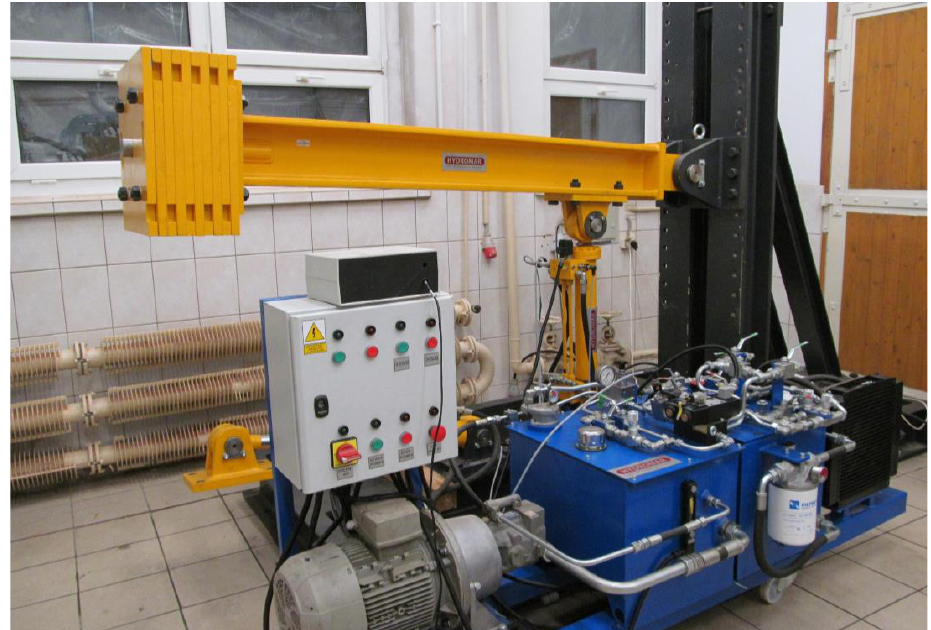
Figure 4. Test stand with visible loading